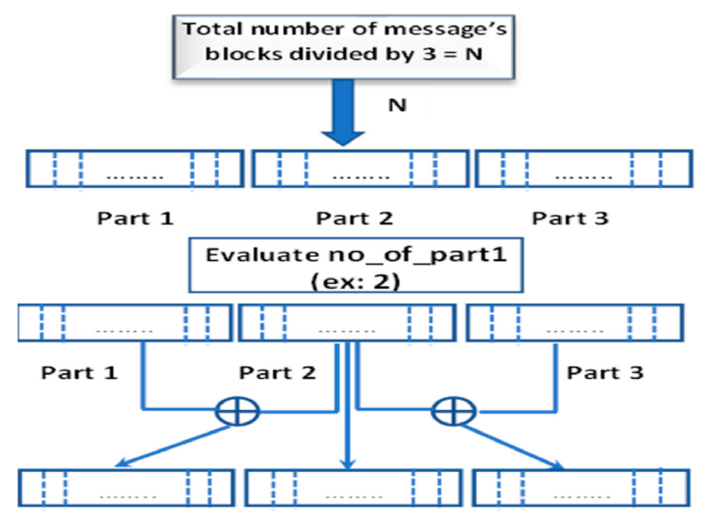
Figure 5. The encryption